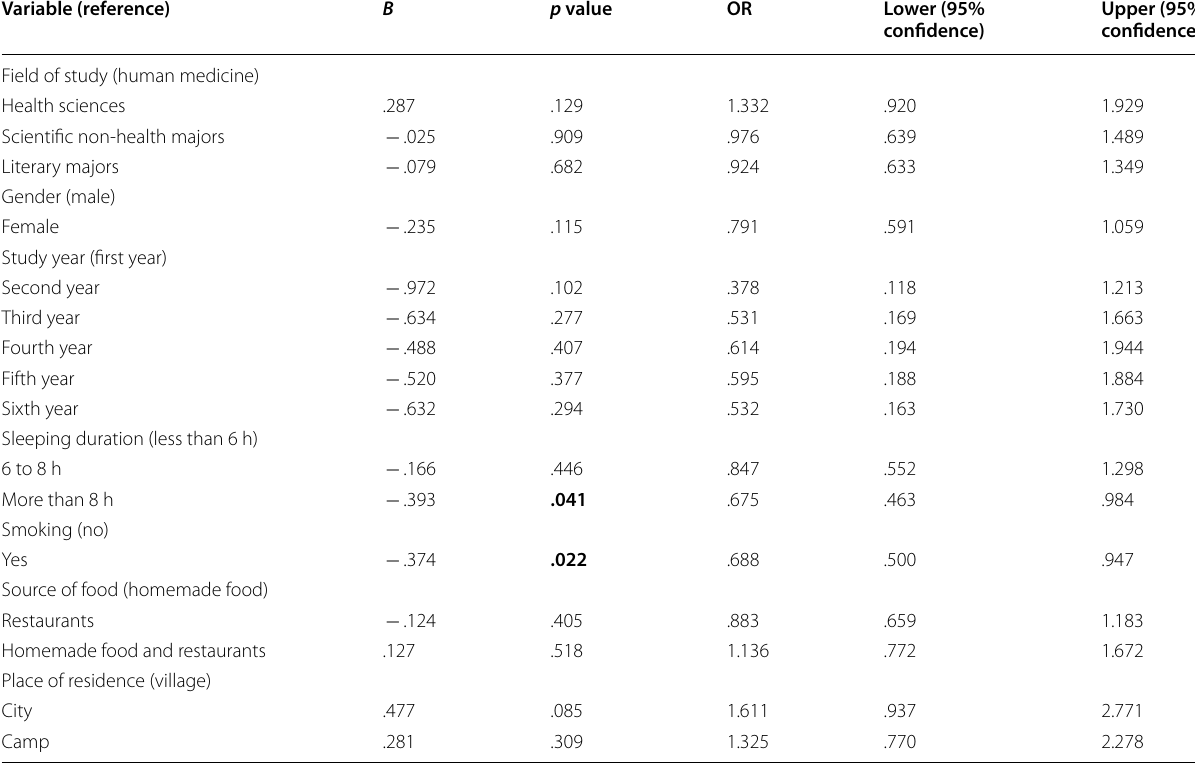
Table 5 Multiple logistic regression analysis of the associations between anxiety and influencing factors Variable (reference) B p value OR Lower (95%